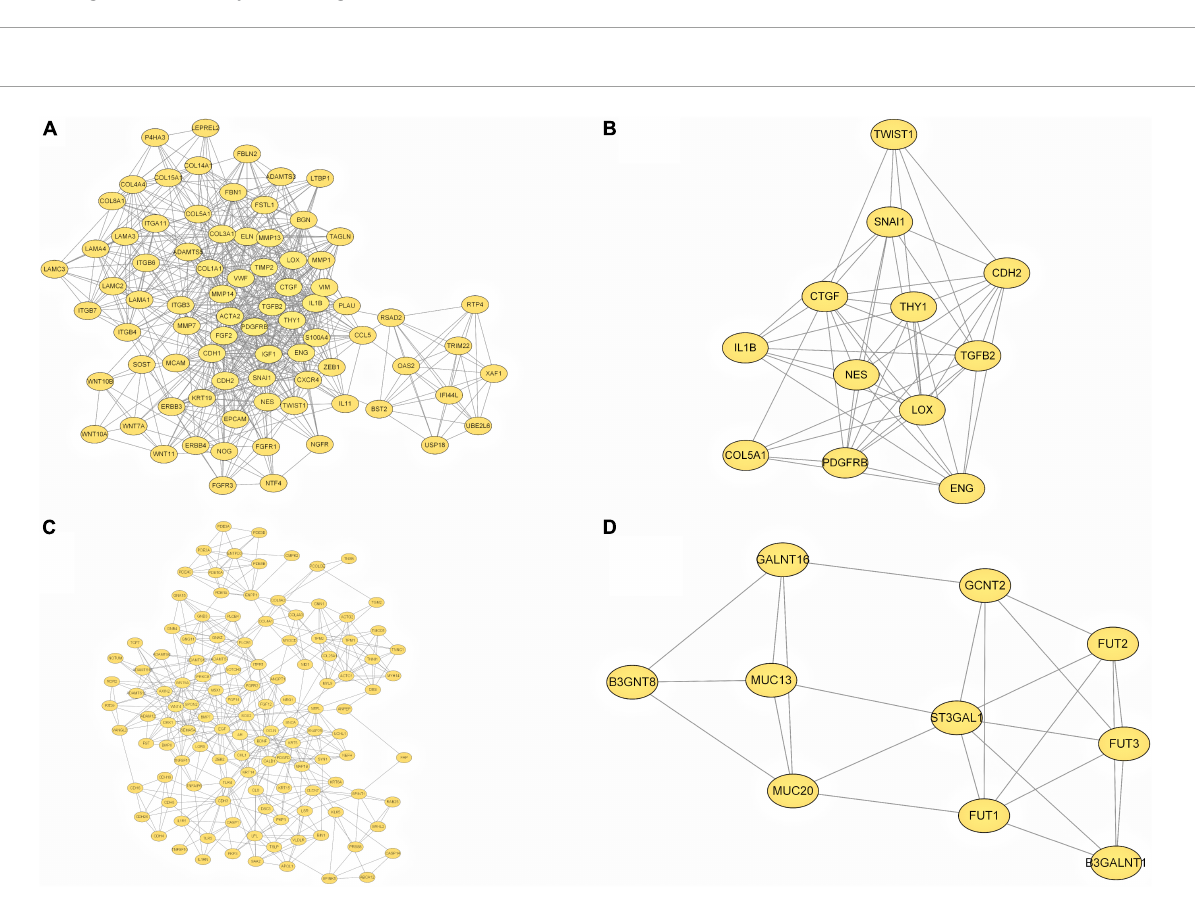
FIGURE6 PPI network based on DEGs. (A–D) The top four interactive density region in the PPI network by “MCODE” plug-in was also